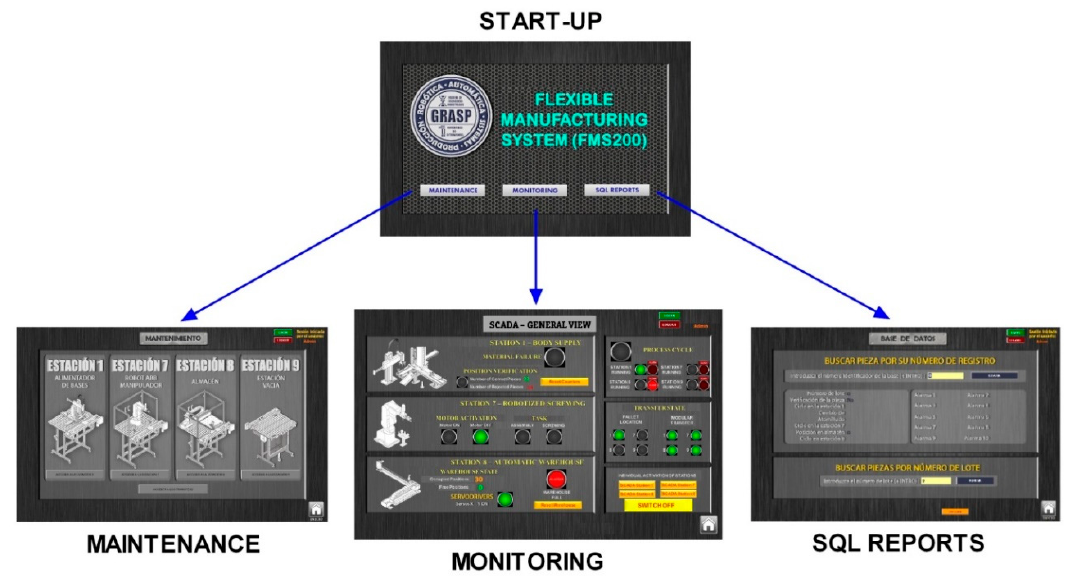
Figure 17. Navigation within the developed SCADA system.